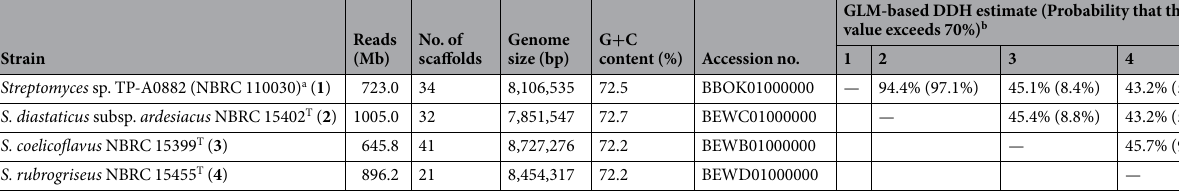
Table 1. Genome sequencing and digital DNA-DNA hybridization (DDH) values estimated by GGDC 2.1. a Data from our previous study 12 . b Distances are inferred using Formula 2 (identities/high-scoring segment pair (HSP) length) from the set of HSPs representing the most unique matches obtained by comparing each pair of genomes. These distances are transformed into values analogous to the DDH using a generalized linear model inferred from an empirical reference dataset comprising real DDH values and genome